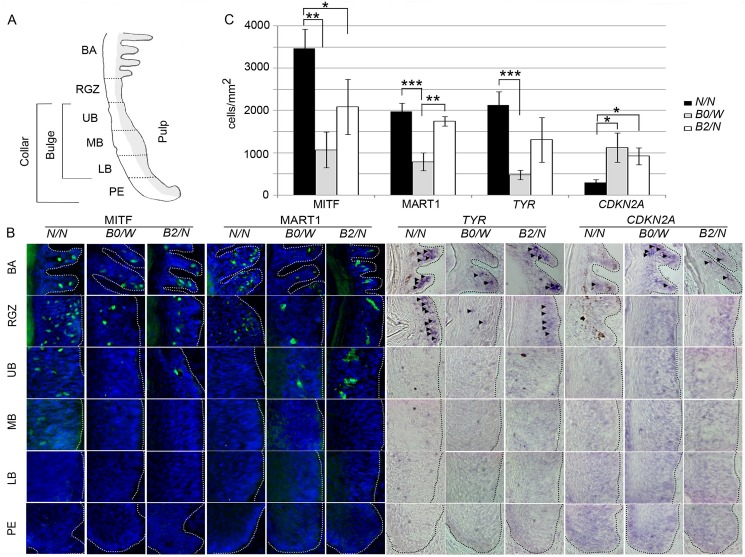
Characterization of the expression of MITF, MART1, TYR and CDKN2A in melanocyte progenitors and differentiated pigment cells in feathers from different genotypes at the Sex-linked barring locus.(A) Anatomy of growing feather, papilla ectoderm (PE), lower bulge (LB), middle bulge (MB), upper bulge (UB), ramogenic zone (RGZ), and barb (BA). (B) Distribution of cells from the melanocyte lineage across different parts of the feather in different genotypes detected by immunohistochemistry (MITF and MART) and in-situ hybridization (TYR and CDKN2A). (C) Average number of MITF+, MART1+, TYR+ and CDKN2A+ positive cells in the barbs of chickens with different genotypes. Significant differences are indicated by stars (One-way ANOVA, Tukey’s multi-comparison post-hoc test; * P<0.05, ** P<0.01, *** P<0.001).